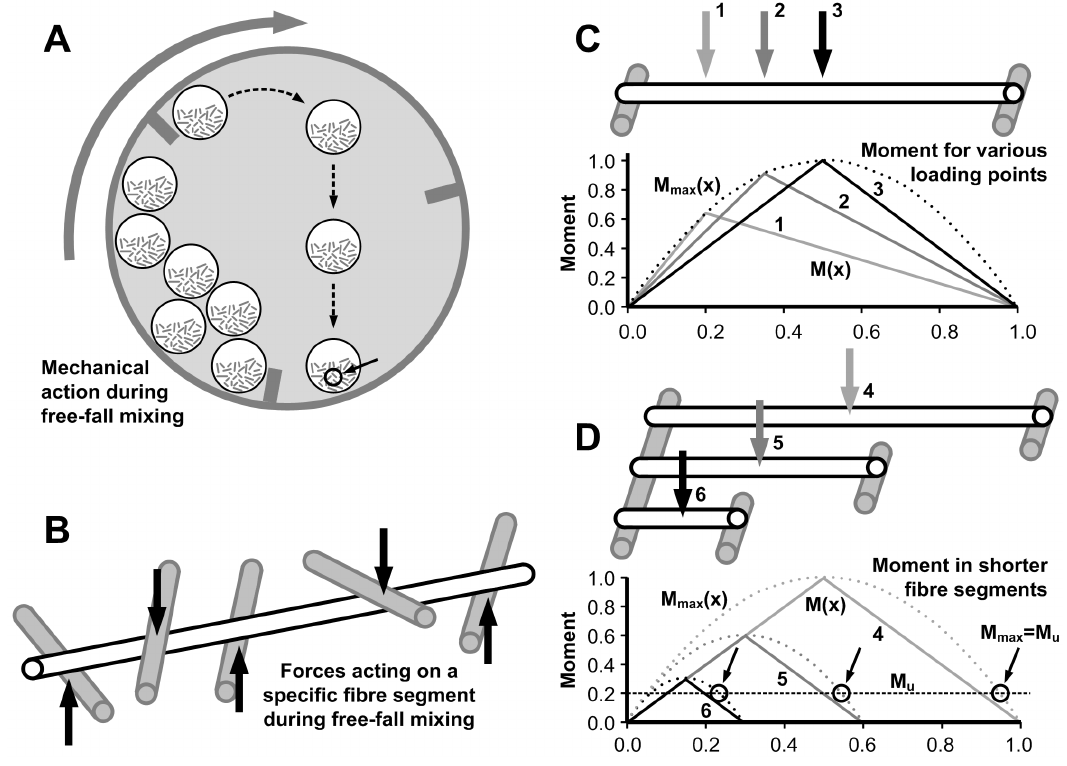
Figure 1. Simulation of fibre attrition during free-fall mixing (A) using beam theory for three-point bending. The mechanical action on fibres (B) is simplified by assuming that fibres only break where generated bending moments (C) are sufficient to cause failure, i.e. where they equal or exceed the failure moment, M u (D). The probable failure region (PFR) extends over the middle 89%, 82%, and 58% of fibres 4, 5, and 6, respectively due to the difference in fibre length between these three fibres.